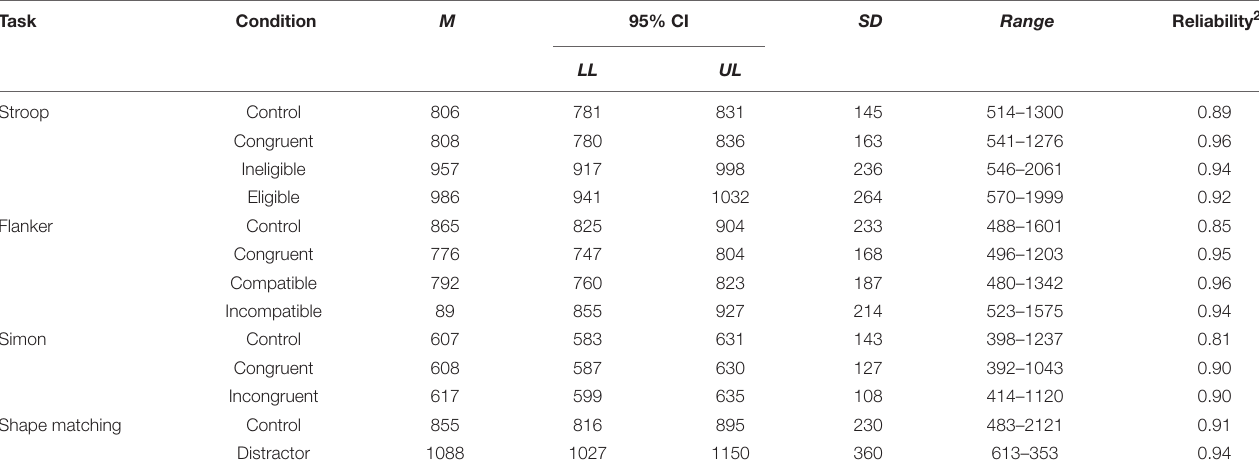
TABLE 3 | Descriptive statistics for the different stimulus-response compatibility task conditions 1 .